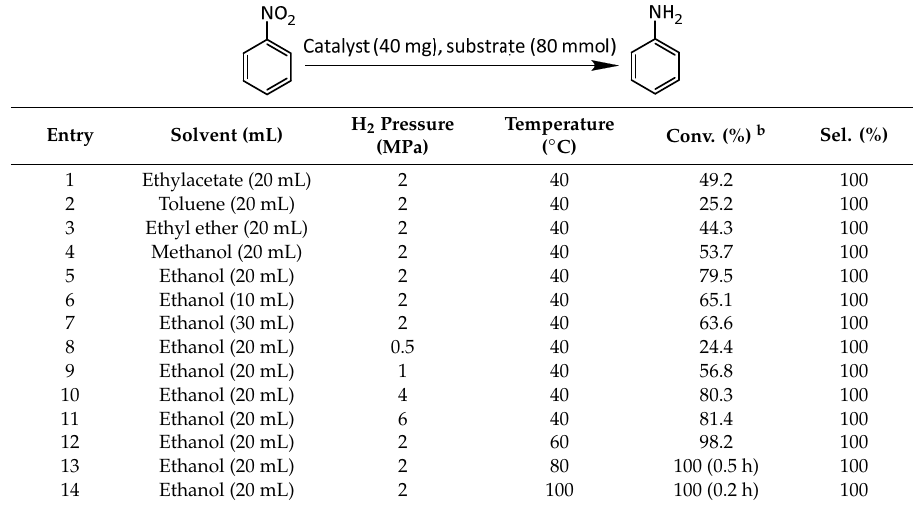
Table 4. Catalytic hydrogenation of nitrobenzene over different catalysts.